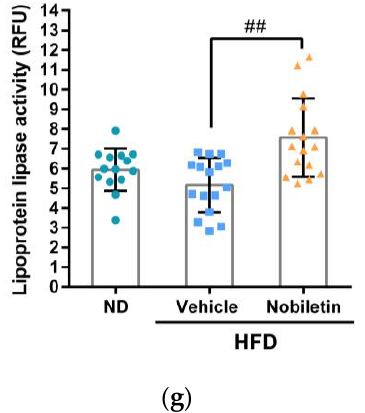
Figure 7. Nobiletin alleviated lipid levels and hepatic ANGPTL3 expression in adult zebrafish. Male adult zebrafish were allocated into three groups: normal diet plus vehicle control (ND), high-fat diet plus vehicle (HFDV) and high-fat diet plus nobiletin (HFDN). The zebrafish were administered vehicle or nobiletin (100 mg/kg) by oral gavage (one dose every two days) for two weeks. The ( a ) body weight, ( b ) AST activity, ( c ) triglyceride and ( d ) cholesterol contents were analyzed as described in Materials and Methods. Values are expressed as the means ± SD. # p < 0.05 and ## p < 0.01 represent significantly statistical differences compared to the ND- or vehicle-treated groups. ( e ) The protein extracts of livers from 6 individual zebrafish in respective ND, HFD/Vehicle, and HFD/Nobiletin groups (NDV#1 ~ #6, HFDV#1 ~#6, and HFDN#1~#6) were prepared and the ANGPTL3 and β -actin proteins were detected by Western blotting analysis. A representative blot is shown. ( f ) The intensity of the protein signal for ANGPTL3 and β -actin was measured in different blots from replicate experiments. The normalized values of ANGPTL3 versus β -actin from 6 individual zebrafish in respective groups (NDV#1 ~ #6, HFDV#1 ~#6, and HFDN#1~#6) are expressed as the means ± SD. # p < 0.05 represents significantly statistical differences compared to the HFD/Vehicle-treated groups. ( g ) The protein extracts of livers (10 μg) from zebrafish treated with ND (n = 14), HFD/Vehicle (n = 16) and HFD/Nobiletin (n = 16) groups and LPL enzyme were incubated with substrates to determine the LPL activity via fluorogenic analysis. The fluorescence intensity was measured at 90 min. The data represent the mean ± SD. ## p < 0.01 represents significantly statistical differences compared to the vehicle-treated groups.